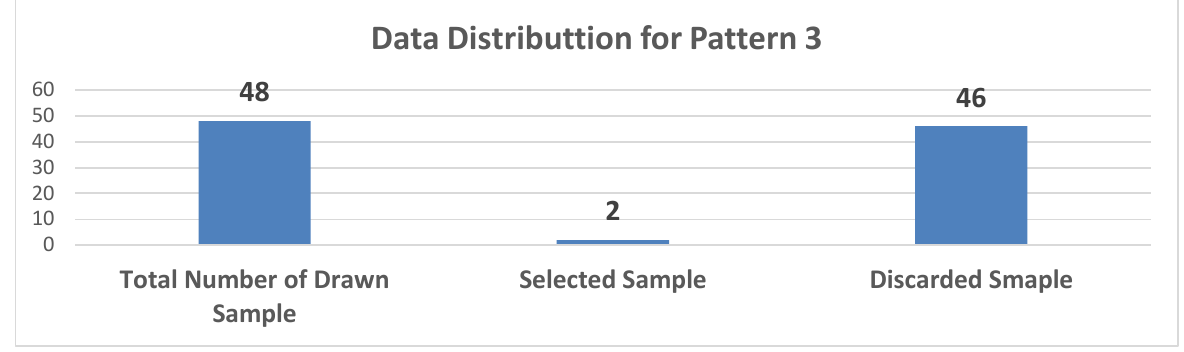
Figure 3: Data Distribution for Pattern